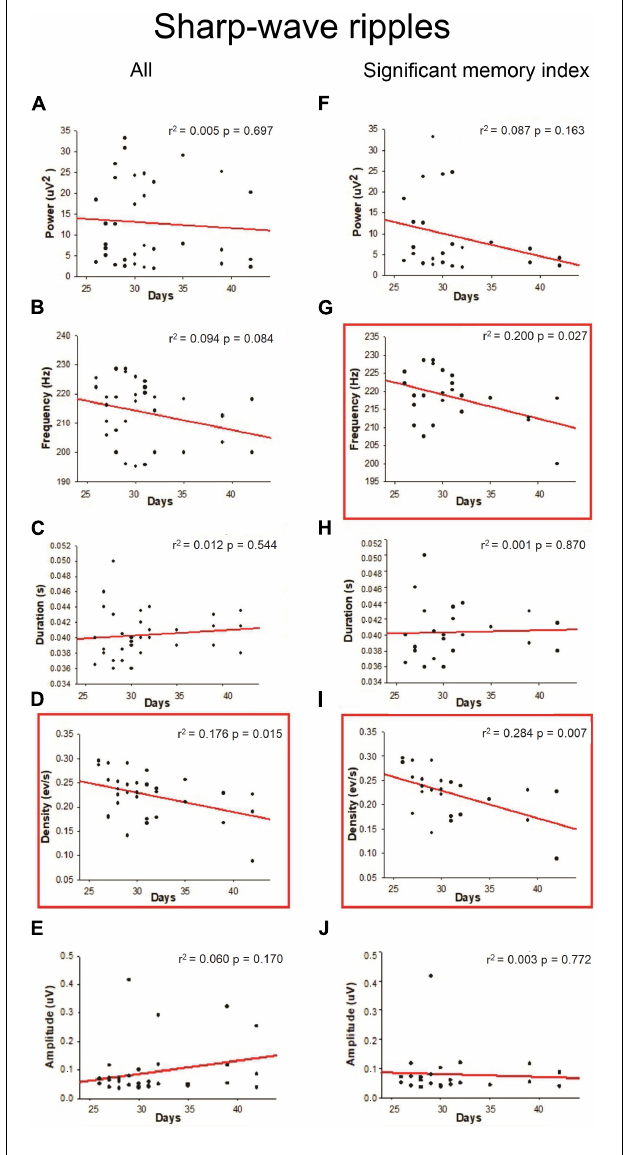
FIGURE 5 | Linear regression between Spindles oscillation features with respect to postnatal days. For each postnatal day, the power (A,F) , frequency (B,G) , duration (C,H) , density (D,I) , and amplitude (E,J) were computed. The correlation analysis considered "All" animals (column on the left) or those with a "significant memory index" (column on the right). The r 2 and p -value are indicated on each regression. No significant regressions were detected.